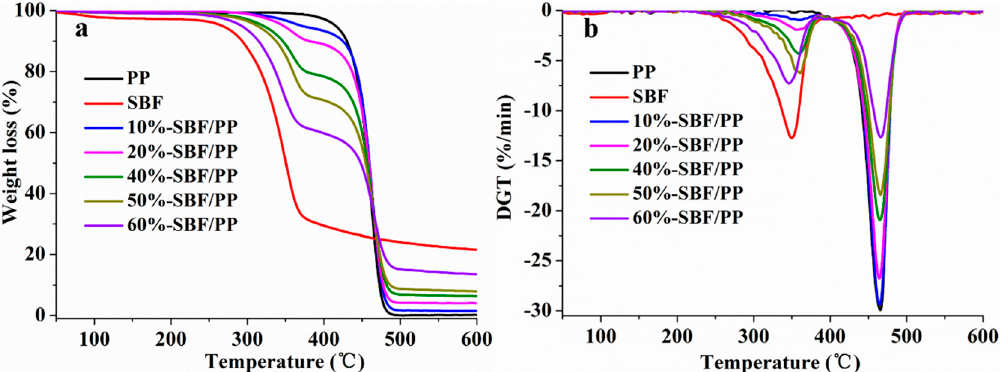
Figure 9. Thermogravimetric analysis ( a ) and derivative thermogravimetric analysis ( b ) curves of PP, SBFs, and the composites with different SBF content.